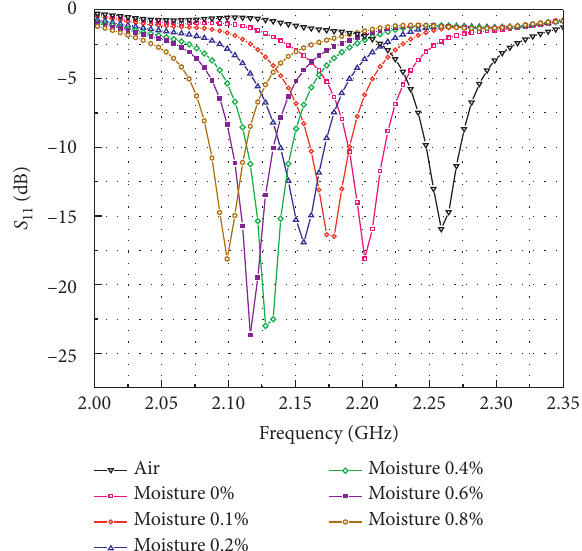
Figure 10: Measuring the moisture content of the lubricating oil in the microfluidic